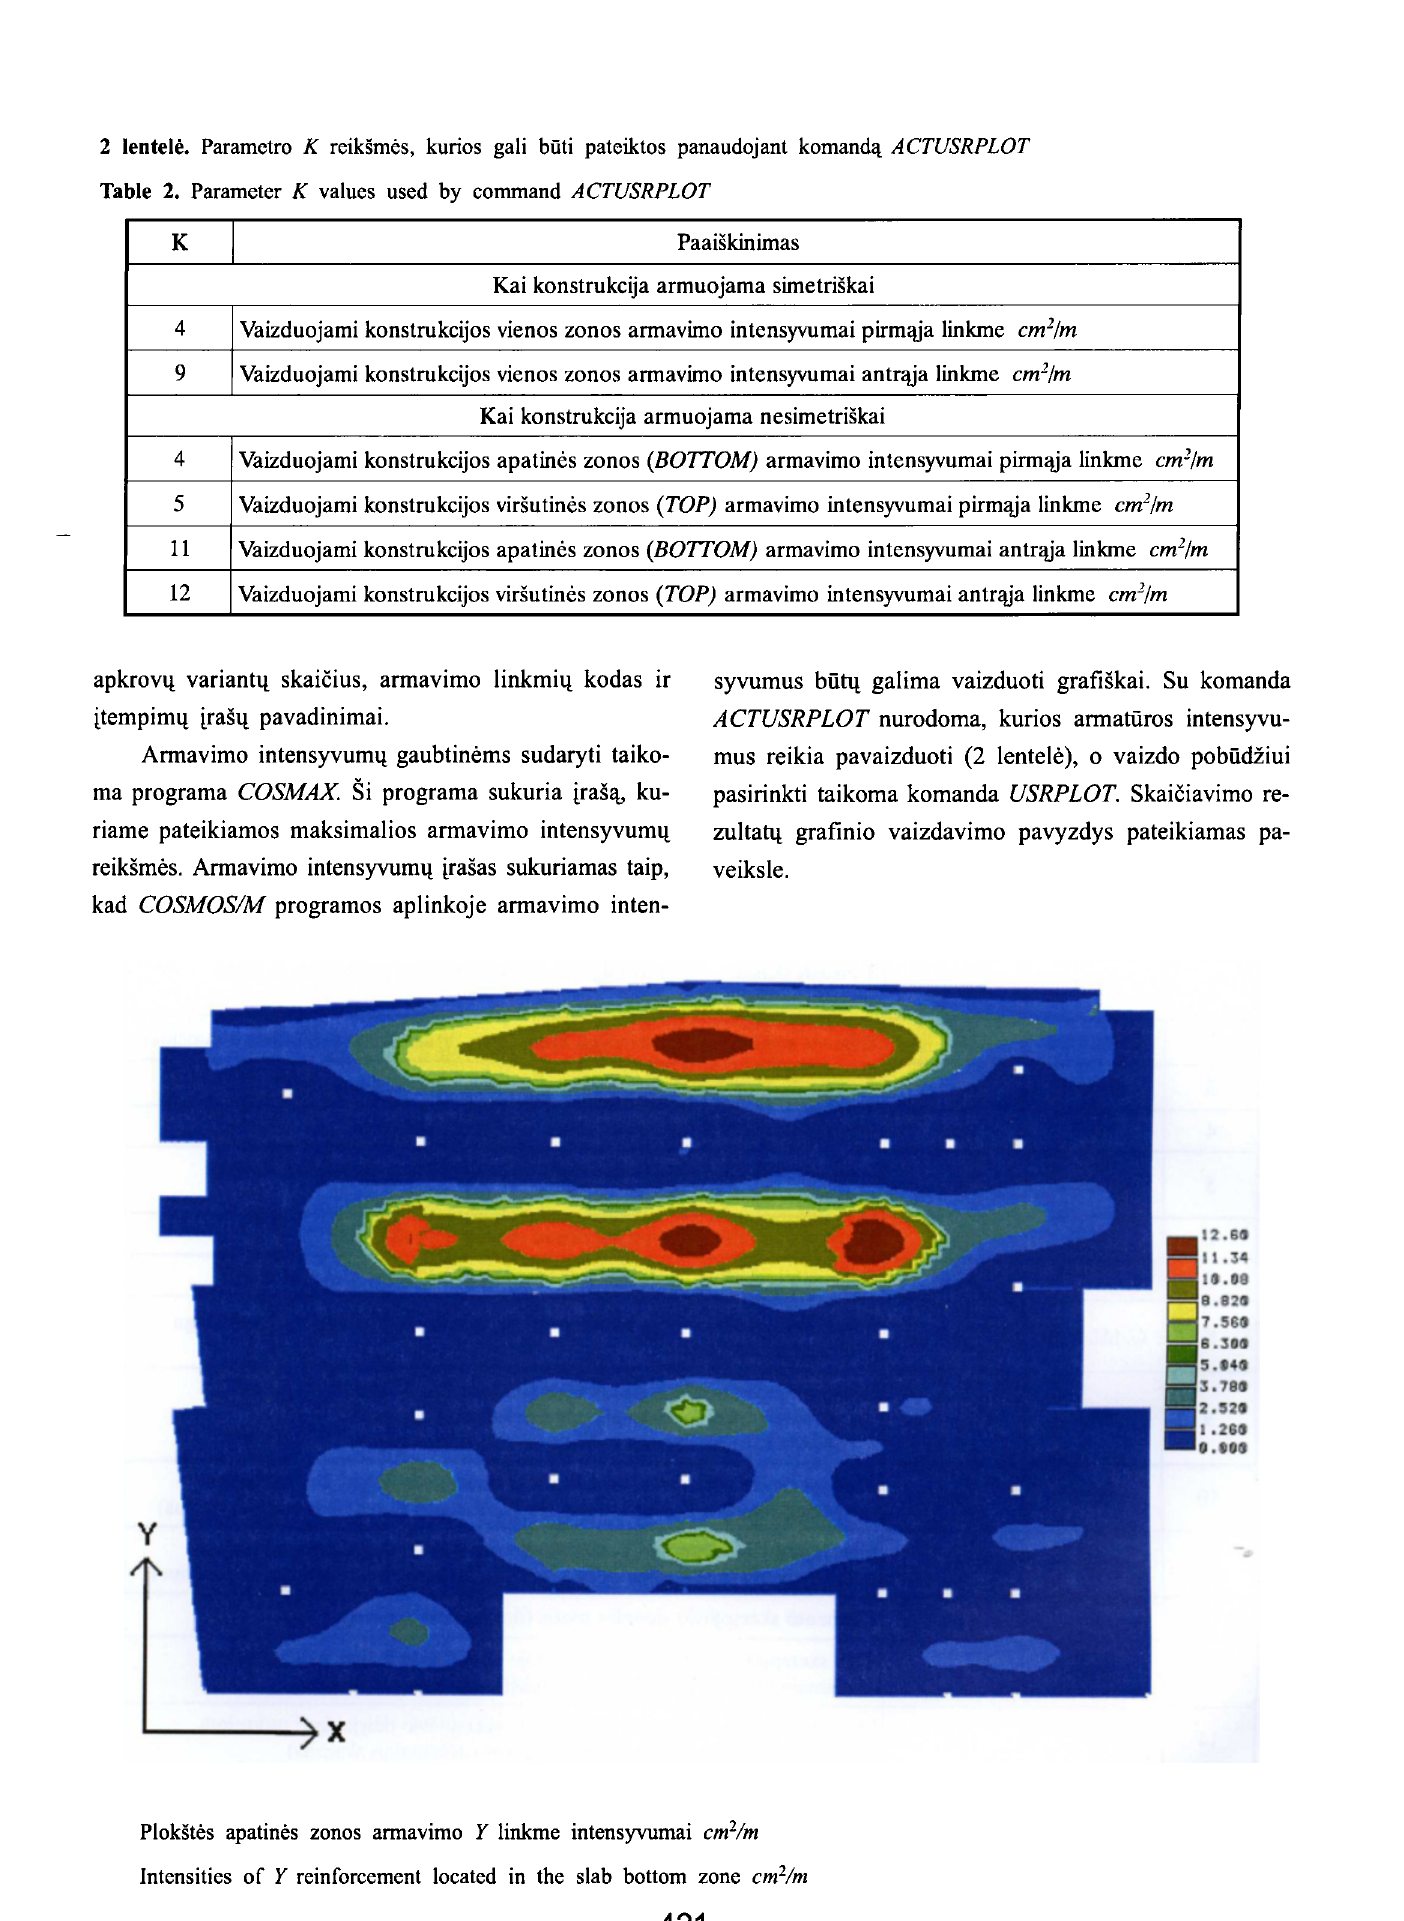
Table 2. Parameter K values used by command ACTUSRPLOT K Paaiskinimas